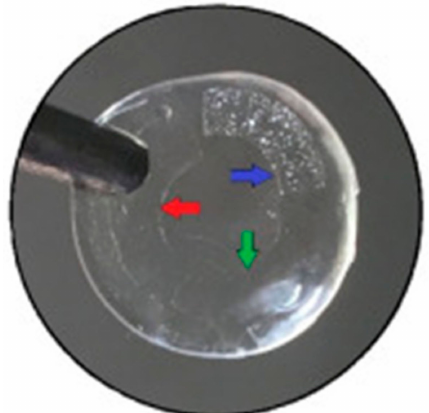
Figure 5. CL with multiple implants in the periphery, highlighted by red, green, and blue arrows. Reproduced with permission from [42], @Copyright 2020,